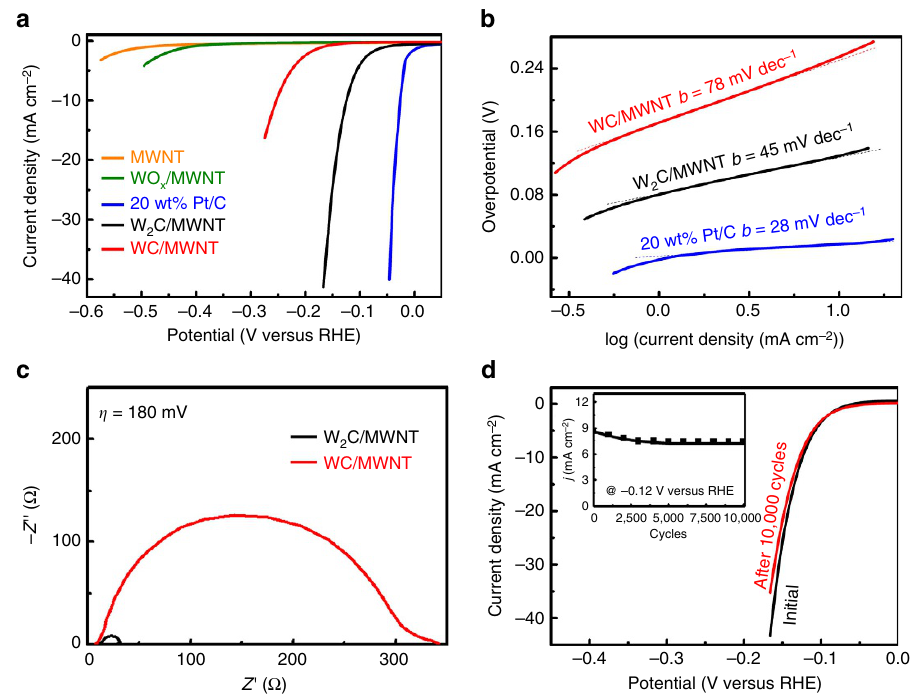
Figure 4 | Electrochemical measurements of W 2 C/MWNT for HER in 0.5M H 2 SO 4 . ( a ) Polarization curve of W 2 C/MWNT in comparison with 20wt% Pt/C, WC/MWNT, WO x /MWNTor MWNTs alone. ( b ) Tafel plot of W 2 C/MWNT in comparison with 20 wt% Pt/C and WC/MWNT. ( c ) Electrochemical impedance spectrum of W 2 C/MWNT at Z ¼ 180mV in comparison with WC/MWNT. ( d ) Polarization curve of W 2 C/MWNT before and after 10,000 potential cycles. The inset shows the change of HER cathodic current density at (cid:2) 0.12V versus RHE with respect to the number of potential